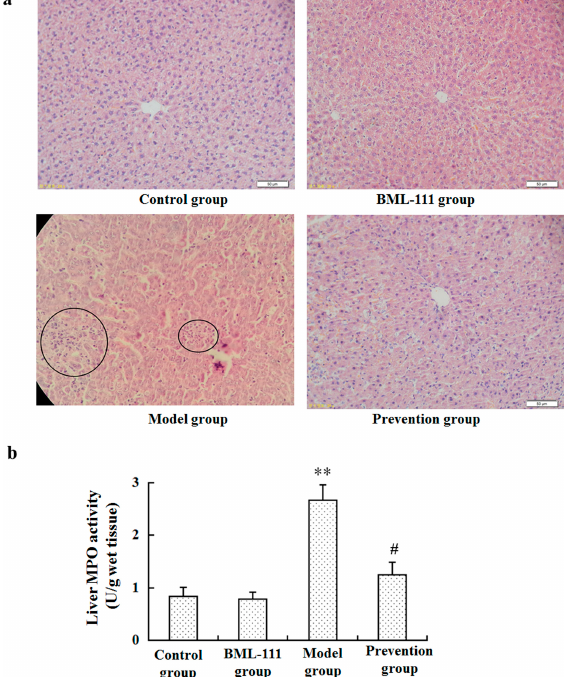
Figure 1. Effect of BML-111 on Lipopolysaccharides and D -Galactosamine (LPS/ D -GalN) induced acute liver injury. ( a ) Haematoxylin and eosin (H&E) staining of livers (original magnification, ×200); ( b ) leukocyte infiltration was evaluated using an myeloperoxidase (MPO) kit according to the manufacturer’s protocols. ** p < 0.01 compared with the control group, # p < 0.05 compared with the model group ( n = 6).